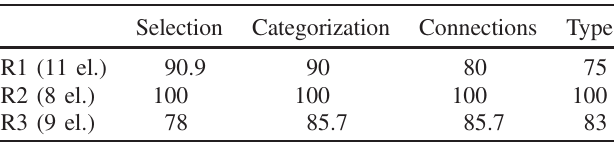
TABLE II. Percentages of agreement between two authors that coded three pieces of data independently (R1, R2, and R3). For each piece of data, we add the amount of identified elements between brackets (# el.). Reliability is discussed on four levels: the selection of elements, the categorization of elements, the number of connections, and the type of